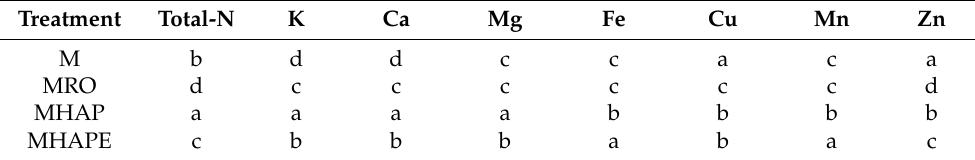
Table 2. Comparison of the mass of elements by different treatment added (before planting) by the manure and manure-biochar application. The mean was calculated and compared for sample size n = 4. Different letters signify statistical differences between treatments at p < 0.05 (column-wise). Treatment Total-N K Ca